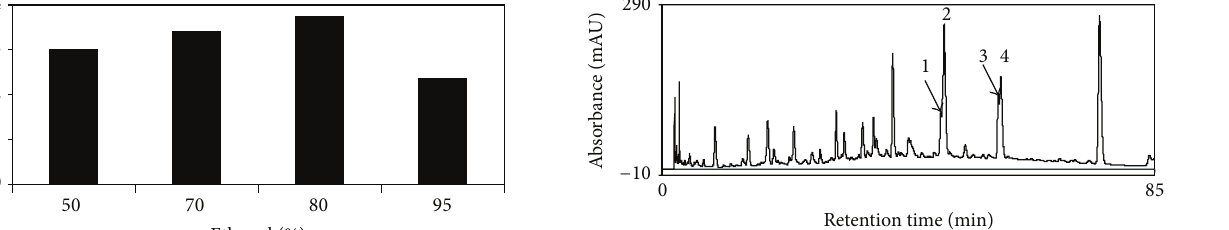
Figure 1: Comparison of the extraction efficiencies of various compositions of aqueous ethanol.